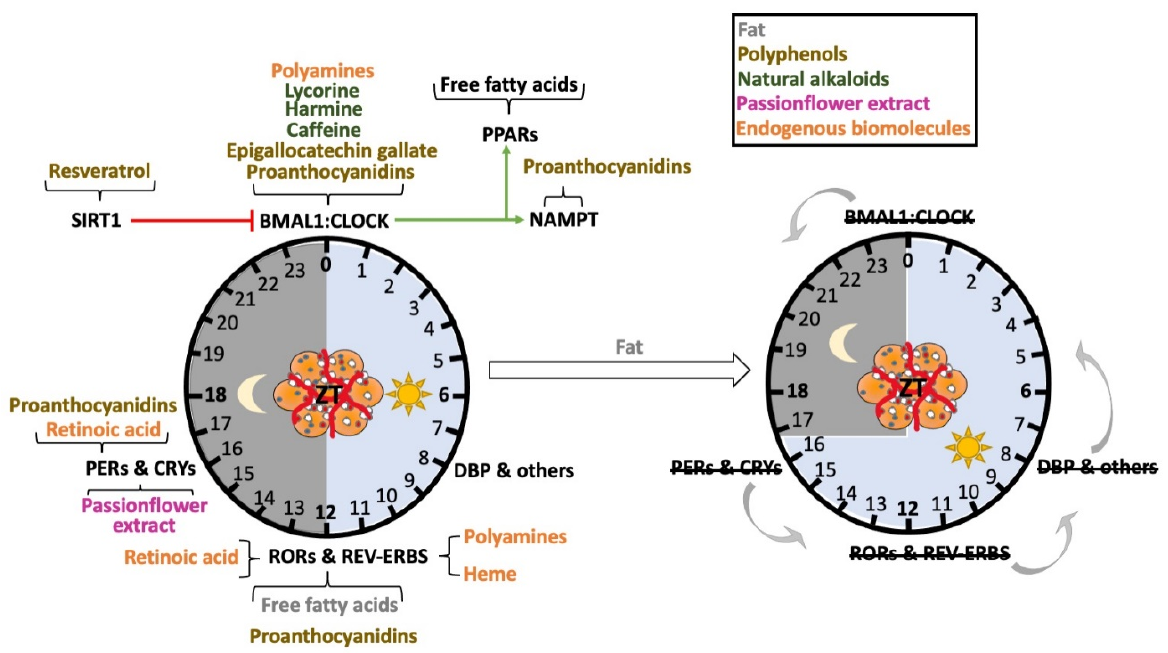
Figure 3. Numerous nutrients function as zeitgebers for the adipose tissue clock. Many xenobiotics and endogenous nutrients can directly or indirectly alter clock function via regulation of circadian clock genes ( left ). Specific molecules reported to affect unique clock genes are shown on the left. Excess fat in the diet appears to not only cause a phase advance in the core clock genes ( right , gray arrows to the left), but also causes changes in period length. These observations come in part from the use of circadian clock gene reporter mice, which can be analyzed for the circadian phase using bioluminescence.